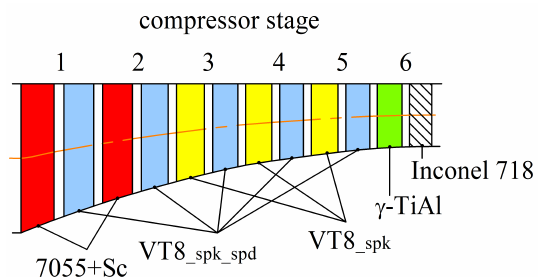
Figure 11. Materials recommended for individual compressor